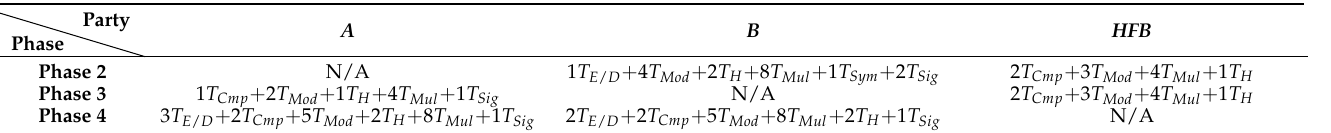
Table 5. Analysis of the communication cost.